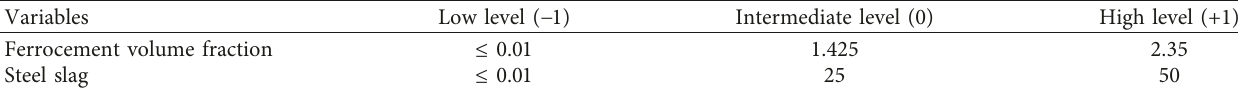
Figure 1: Step-by-step approach to achieve response models and optimisation. Table 1: Levels of